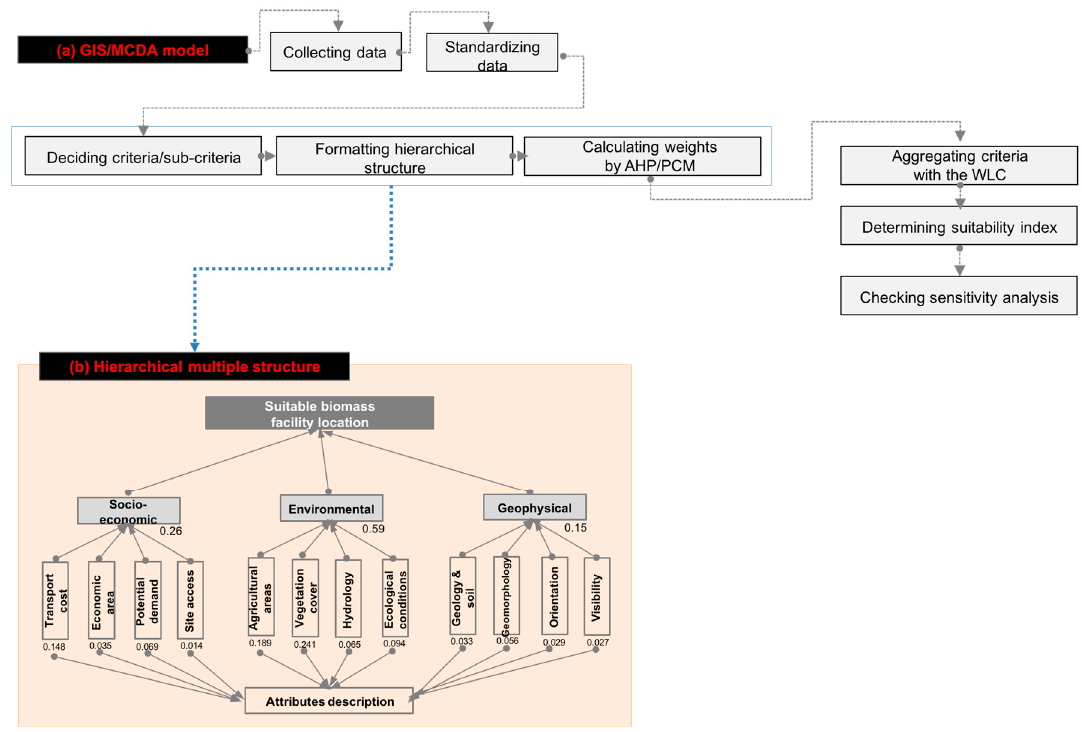
Figure 2. Schematic diagram for biomass facility location optimization.